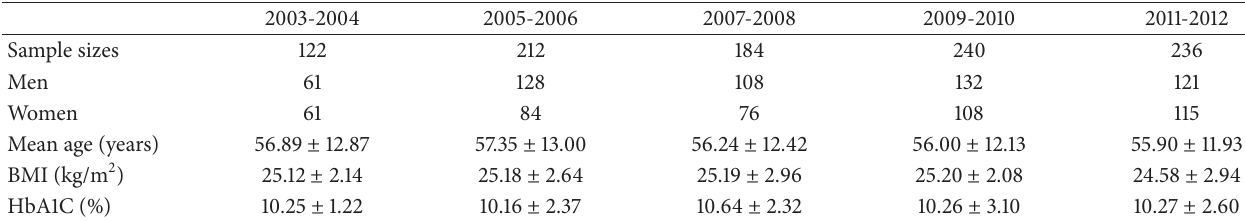
Table 1: Patient characteristics.